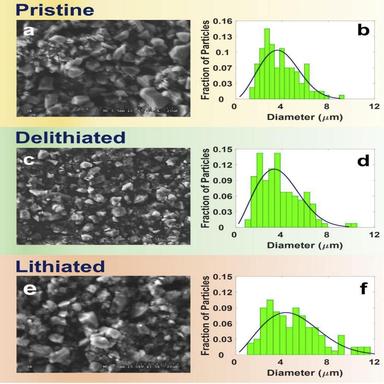
SEM images and corresponding PSD profiles of SiO particles in anodes at (a,b) pristine state (before cell-fabrication), (c,d) delithiated state, and (e,f) lithiated state. The scale bars on the SEM images are 20 μm.